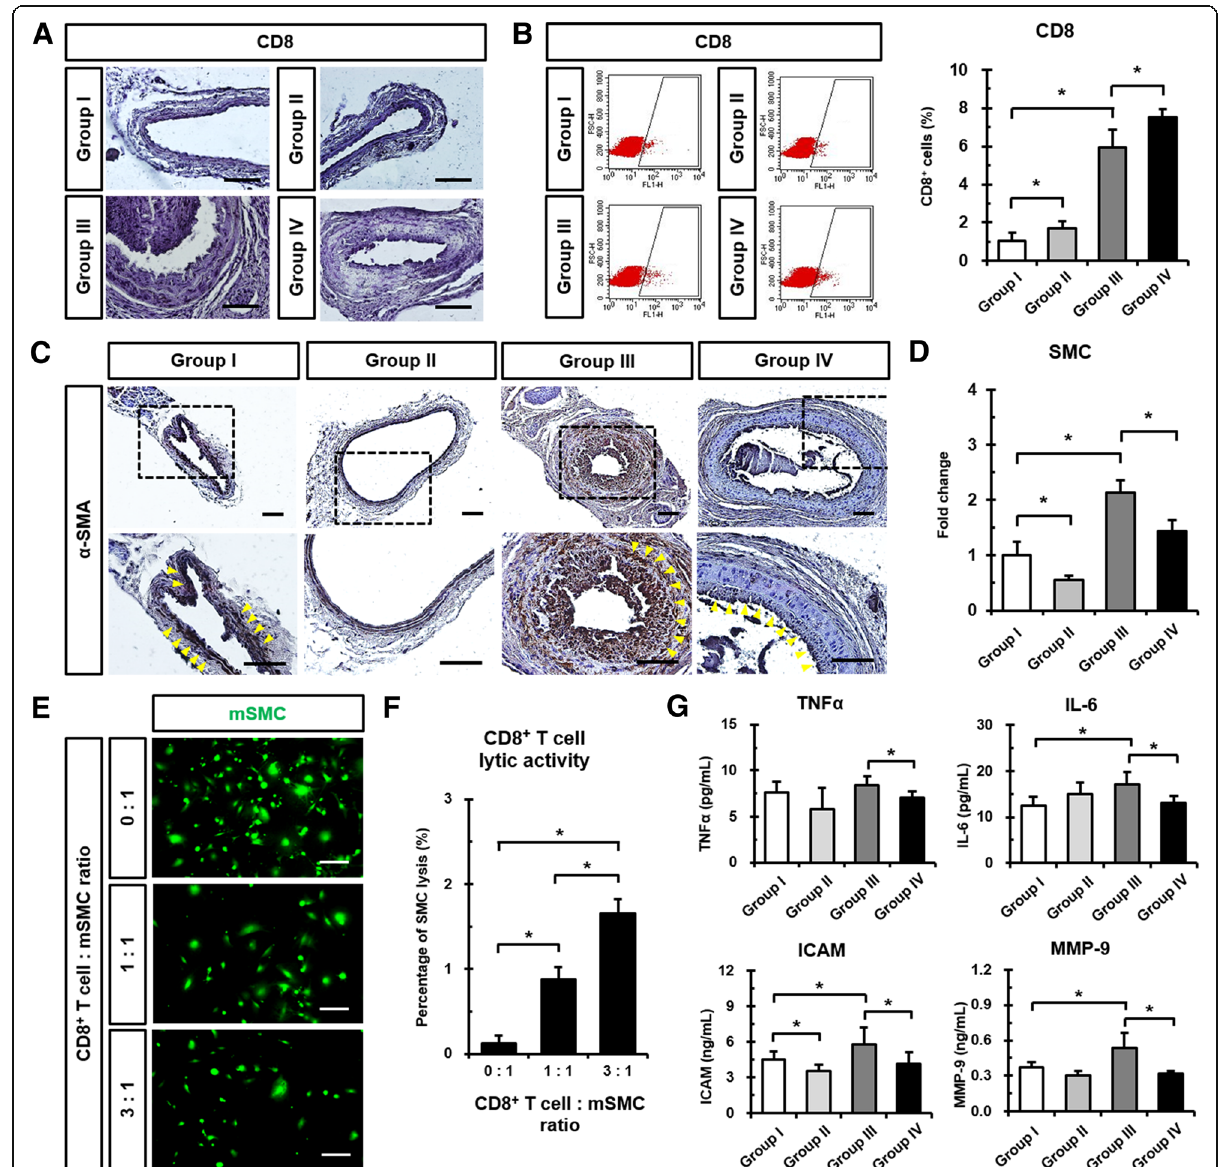
Fig. 3 Effects of Fimasartan on CD8 + T cells, SMCs, and cytokines/chemokine expression after CA injury. a Immunohistochemical images showing the expression of CD8 + T cells (brown) in CA at 28 days after CA injury and/or fimasartan administration. Scale bar: 100 μ m. b Representative pictures showing that CD8 + T cell subsets were gated using Flow cytometry. Results of statistical analysis of CD8 + T cells in peripheral blood at 28 days after CA injury and/or fimasartan administration. c Representative immunohistochemical images of α -SMA + expression in CA, showing reduced SMCs (brown) after fimasartan administration. Boxed regions were magnified in the under panels. Yellow arrows indicate α -SMA + cells in CA. Scale bar: 100 μ m. d Quantification of SMCs in CA at 28 days after CA injury and/or fimasartan administration. Data shown represent the mean ± SD on 48 sections (two fields per section, two sections per CA, n = 12 for each group). e Fluorescent images of CD8 + T cell lytic activity assay against SMCs. CFDA SE-labeled mSMCs were co-cultured for 4 h at a CD8 + T cell to mSMC ratio of 0:1, 1:1 or 3:1. f CD8 + T cell lytic activity assay against SMCs examined by flow cytometry. Quantification of PI-positive and CFDA SE-labeled mSMCs. g The plasma levels of inflammatory cytokines/chemokines (TNF α , IL-6, ICAM, and MMP-9). All experimental data are from n = 12 of ApoE KO mice in each group. Values are presented as the mean ± SD. * p < 0.05. NS , not